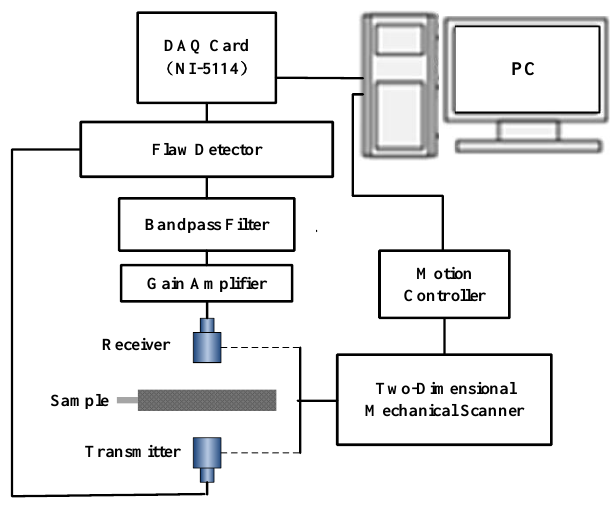
Figure 9. Schematic diagram of the experimental setup.